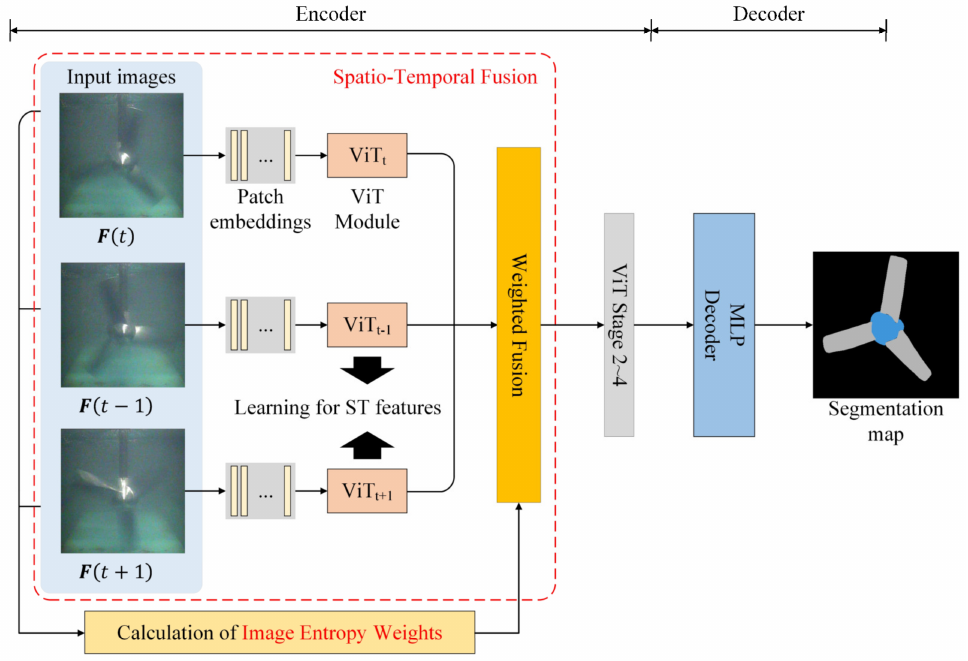
Figure 2. The structure diagram of the proposed IEWSTF-based SS